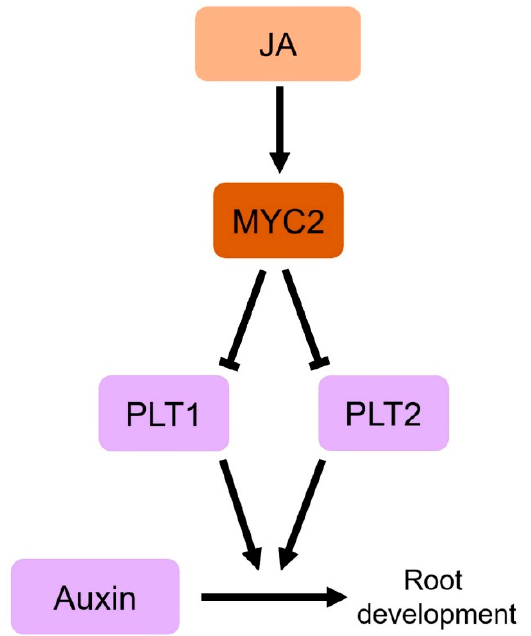
Figure 3. A schematic of crosstalk between JA and auxin in root development. PLT1 and 2 transcription factors are key regulators of root development downstream auxin. JA inhibits root growth, and MYC2 transcription factor mediates this development process by reducing expression of PLT1 and 2 . The arrows and T bars indicate positive and negative regulation, respectively.